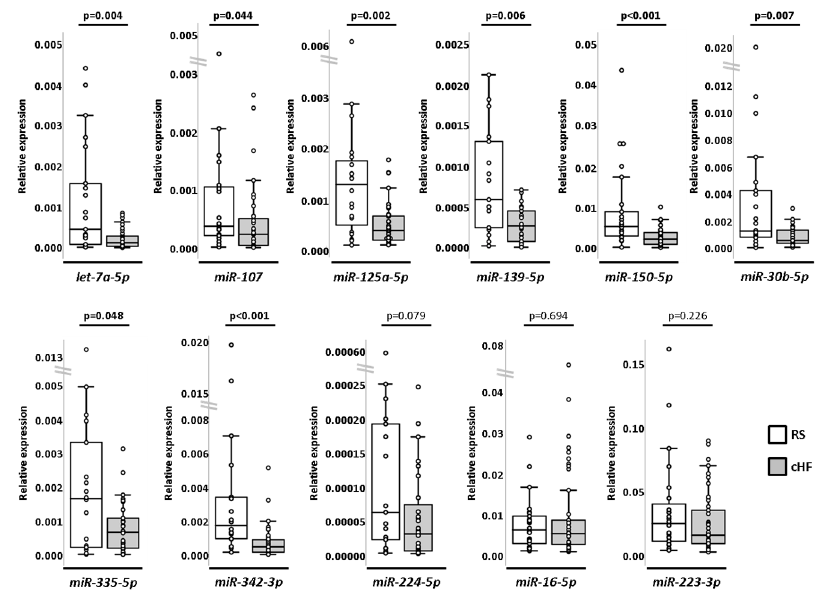
Figure 2. Box and whisker plots of selected miRNAs analysed in cHF ( n = 46) and RS ( n = 26). U Mann–Whitney test. A p -value < 0.05 was considered significant. cHF: chronic heart failure; RS: reference subjects .